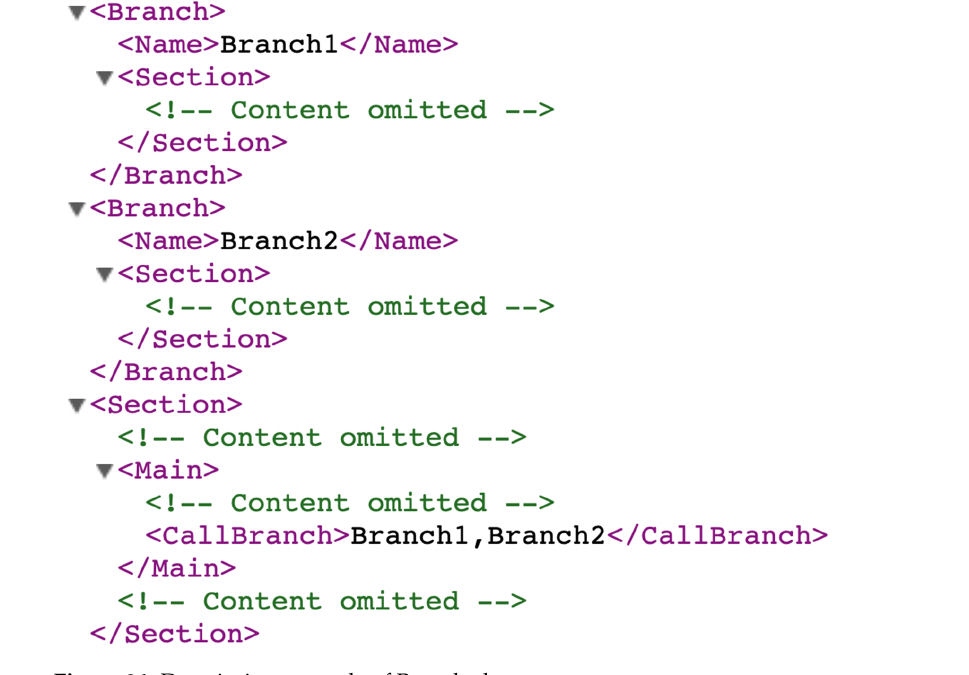
Figure 24. Description example of Branch